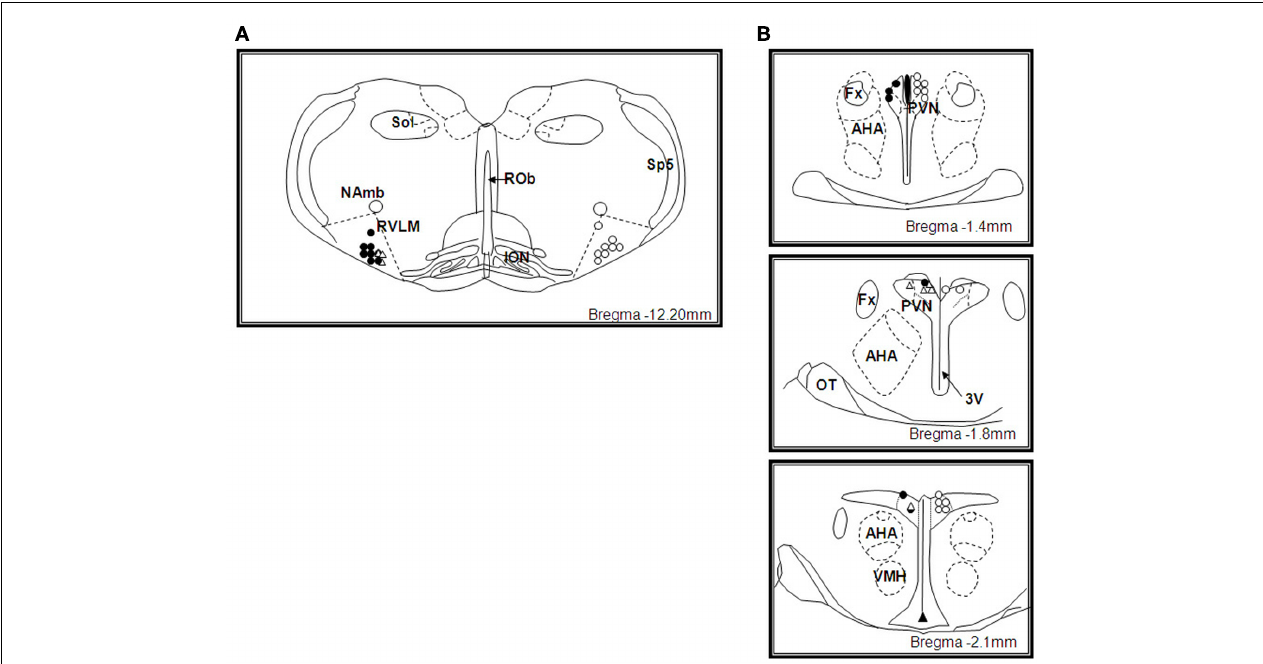
showing the center of the microinjection sites within the hypothalamic paraventricular nucleus (PVN). Microinjections were made bilaterally but only unilateral sites are shown. Filled circles represent microinjection sites of NaHS and unfilled circles represent microinjection sites of amino-oxyacetate and hydroxylamine inWKY rats, unfilled triangles represent microinjection sites of NaHS in SHR rats. Approximate levels caudal to bregma are indicated. Abbreviations: Fx, fornix; AHA, anterior hypothalamic area; 3V, third ventricle; OT, optic tract;VMH, ventromedial